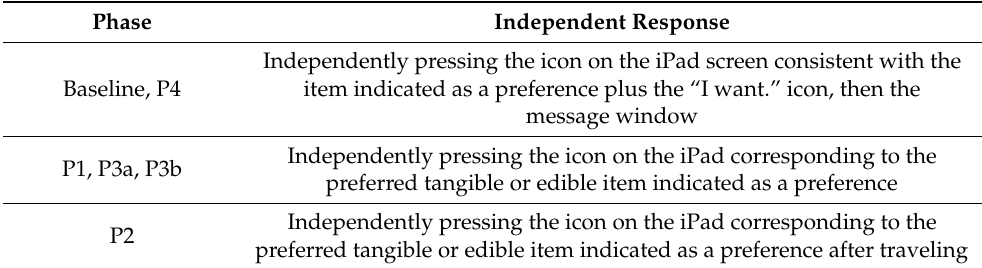
Table 4. Independent response for each phase.